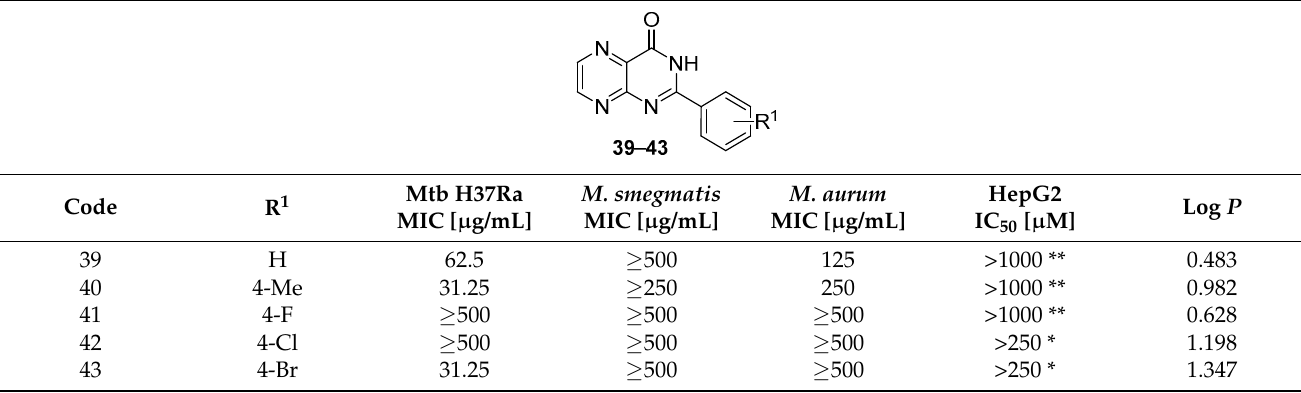
Table 4. Antimycobacterial activity and HepG2 cytotoxicity of compounds’ cyclic (pteridine) derivatives.